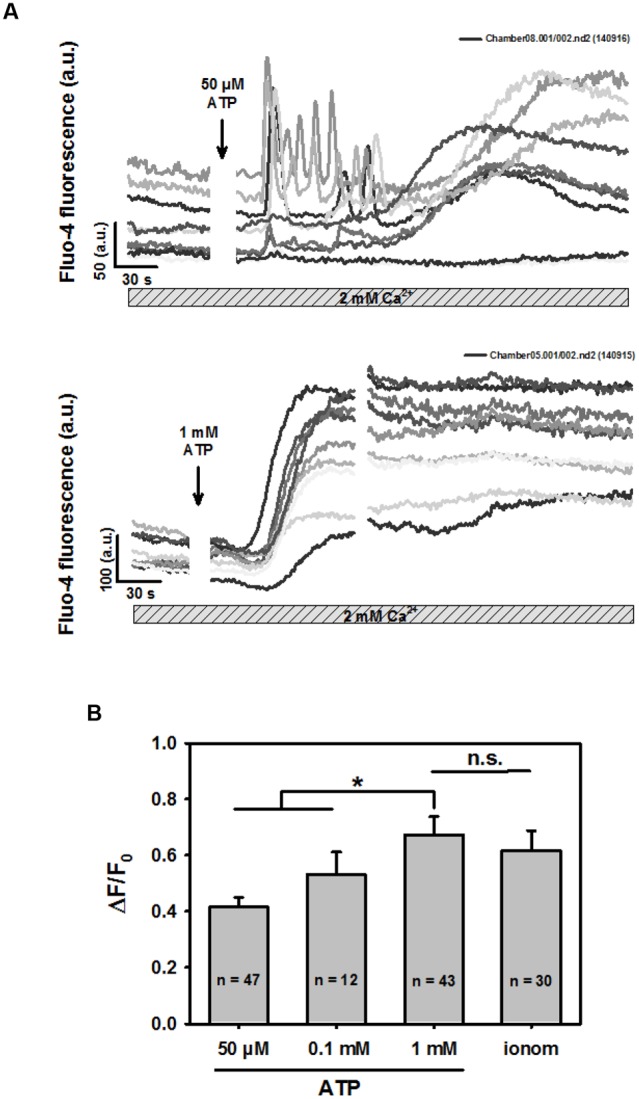
ATP concentration-response for sustained rise in intracellular Ca2+ in BV2 cells bathed in 2 mM external Ca2+. (A) Examples of two-photon fluo-4 recordings in several BV2 cells and P2X receptors stimulated with low (50 μM) and high concentrations (1 mM) of ATP. In particular with low ATP concentrations, Ca2+ oscillations were occasionally observed, followed by a sustained rise in Ca2+. For larger ATP concentrations, almost exclusively sustained Ca2+ responses were observed in this setting. (B) Statistical analysis of ATP-induced ROCE. Low ATP concentration-induced Ca2+-peak of the sustained response was significantly smaller compared with the response to 1 mM ATP. The latter induced a response as maximal as by Ca2+ ionophoresis with 2 μM ionomycin.